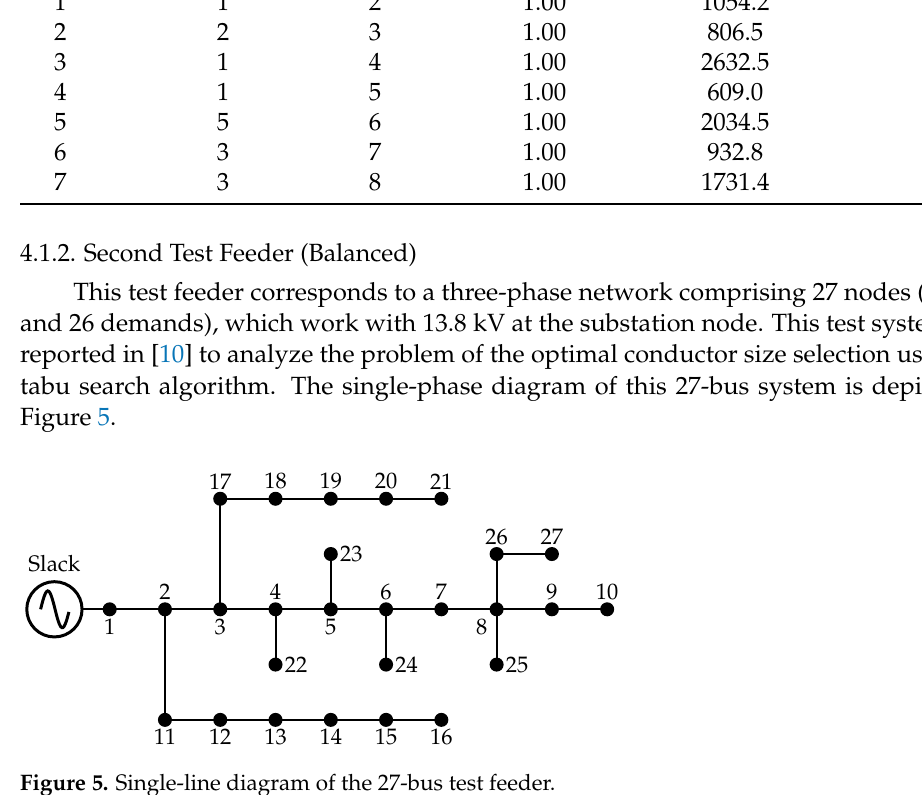
Figure 5. Single-line diagram of the 27-bus test